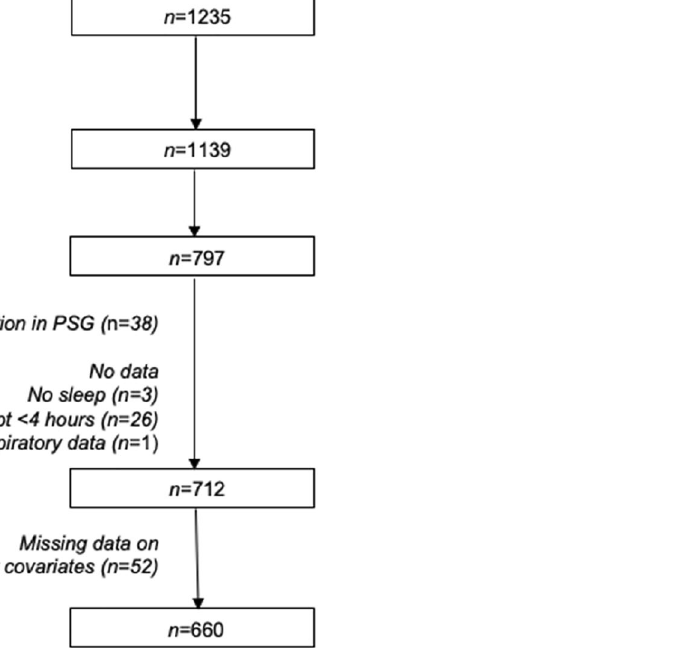
Figure 1. Study flow diagram. PSG =